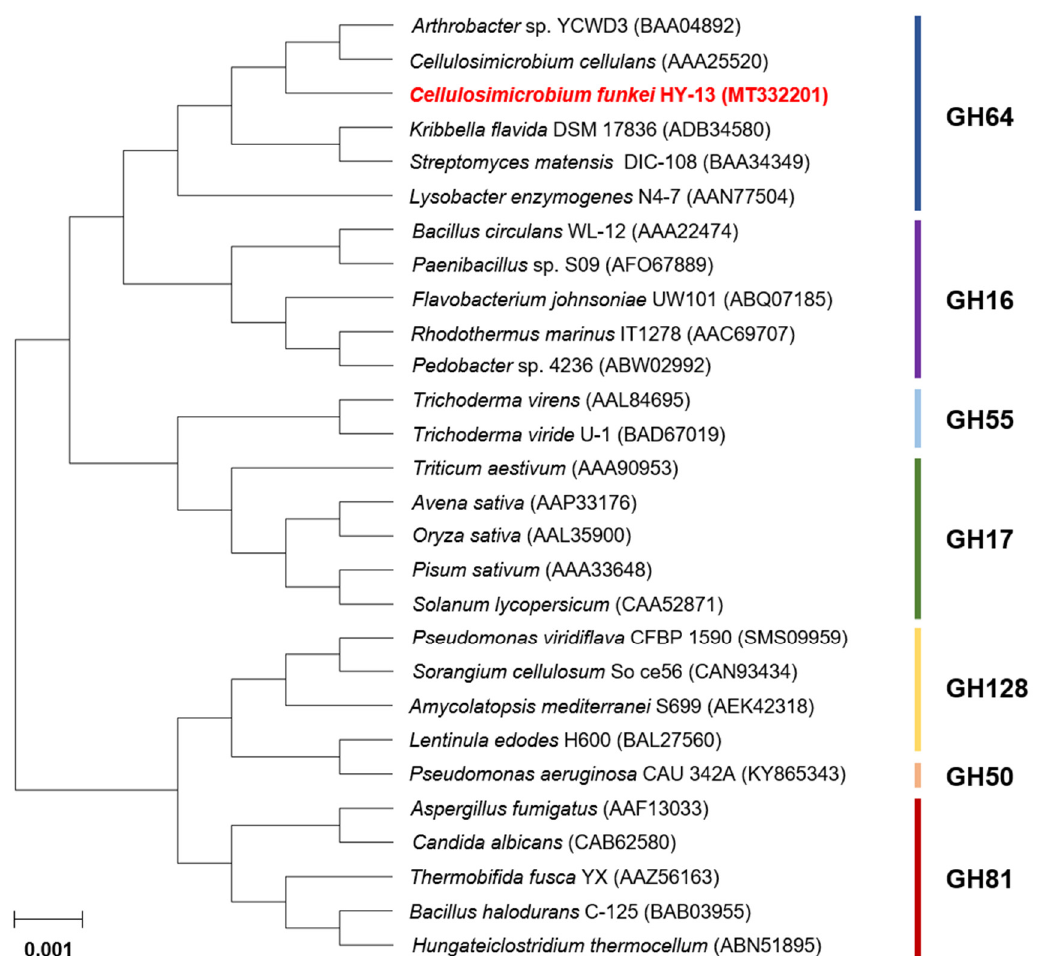
Figure 2. Phylogenetic tree of C. funkei HY-13 GH64 endo- β -1,3-glucanase (GluY) and its closely related functional homologs. Alignment of the amino acid sequences was performed using ClustalW in the MegAlign program (DNASTAR Inc. (Madison, WI, USA)). The protein sequences employed for phylogenetic analysis were retrieved from the GenBank database.